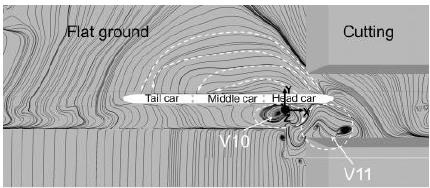
Figure 13. Top view of the streamlines at a height of 0.5 h.